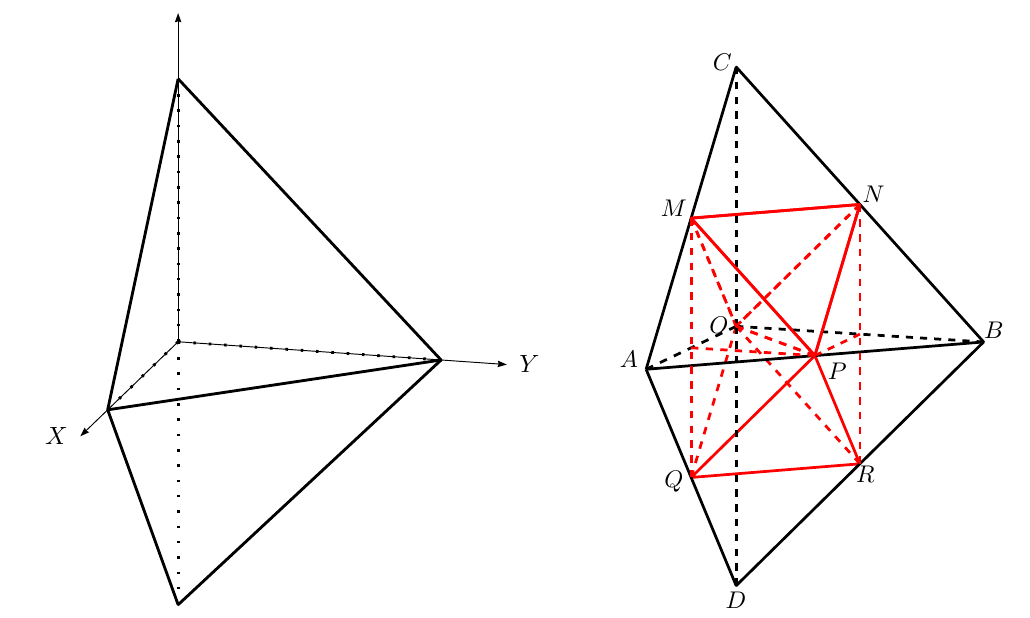
Figure 3. Left: one of the four cells of type T 0 constituting the octahedron. Right: each cell of type T 0 can be subdivided into six cells of type T 1 and two cells of type M 1